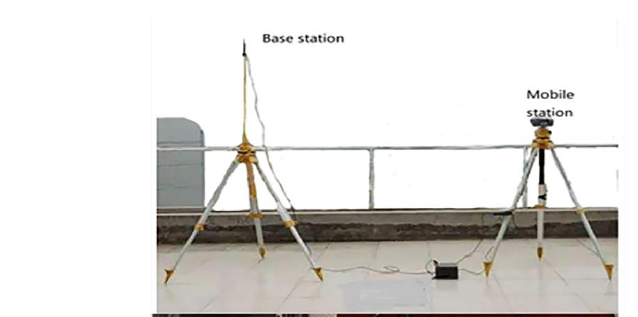
Figure 6. Data acquisition system.